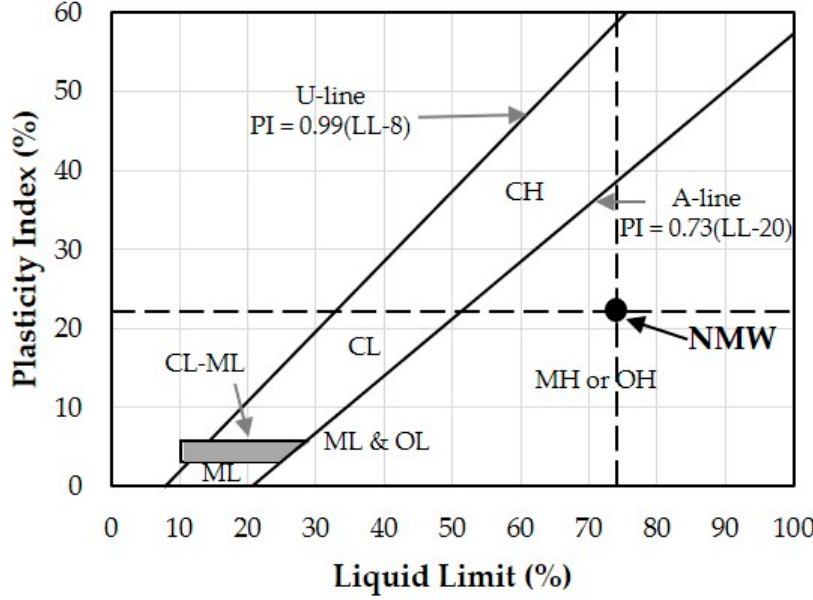
Figure 4. Plasticity Index and Liquid Limit of NMW on the Plasticity chart [34]. Table 3. Summary of classification of soil based on ASTM D 2487 [35] for NMW.